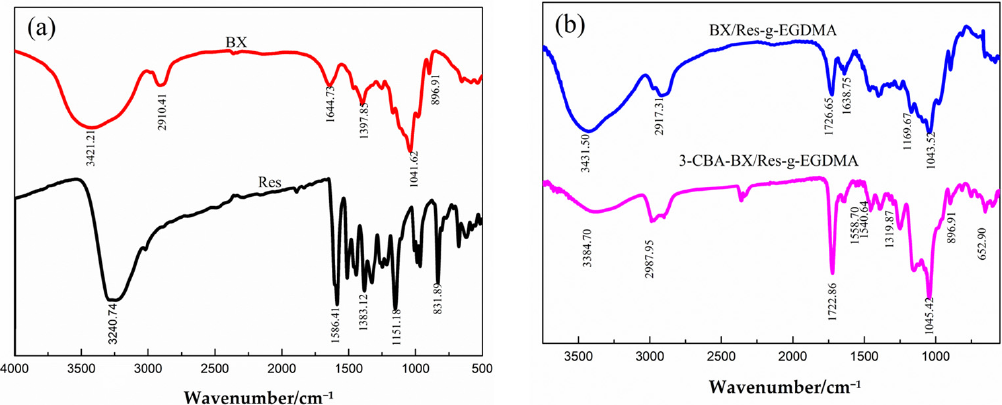
Figure 4. Spectra of BX, Res, BX/Res-g-EGDMA and 3-CBA-BX/Res-g-EGDMA. ( a ) FTIR spectra of BX and Res. ( b ) TIR spectra of BX/Res-g-EGDMA and 3-CBA-BX/Res-g-EGDMA.